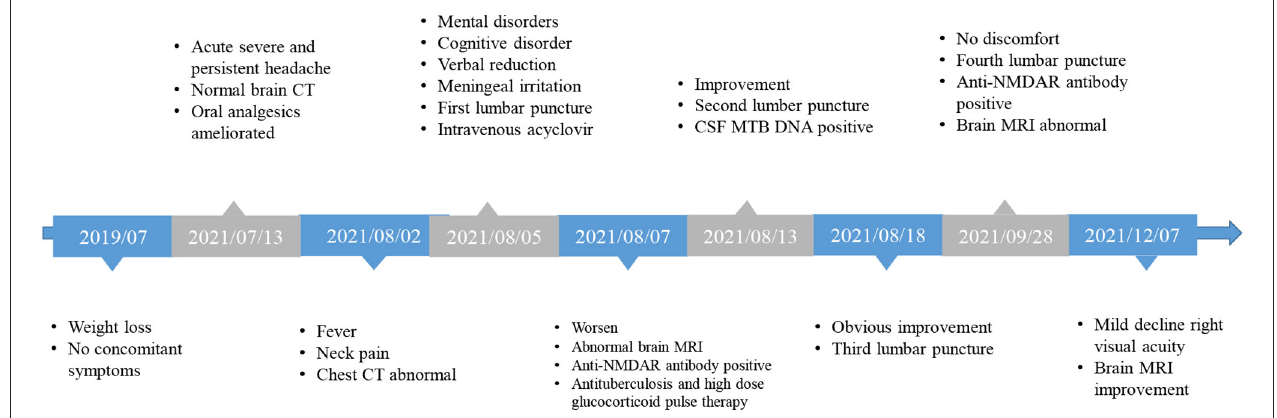
FIGURE 1 | Timeline of the clinical